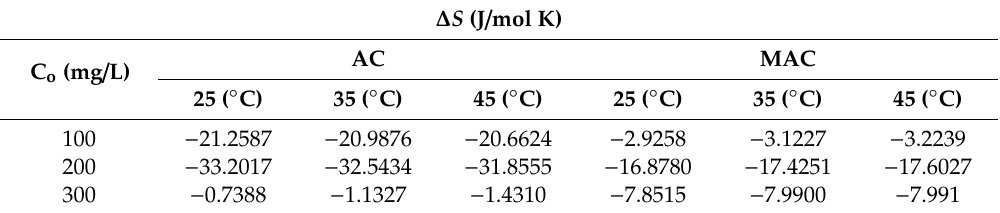
Table 7. Entropy change at 100, 200, and 300 ppm at 25, 35, and 45 ◦ C for AC and MAC. ∆ S (J / mol